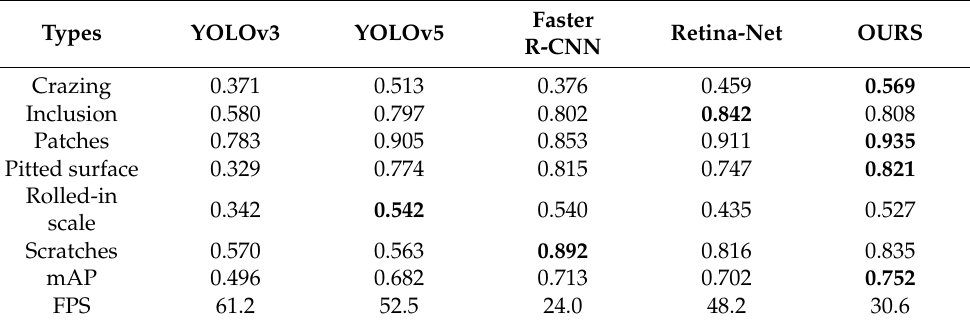
Table 2. The comparison of detecting results on NEU-DET.